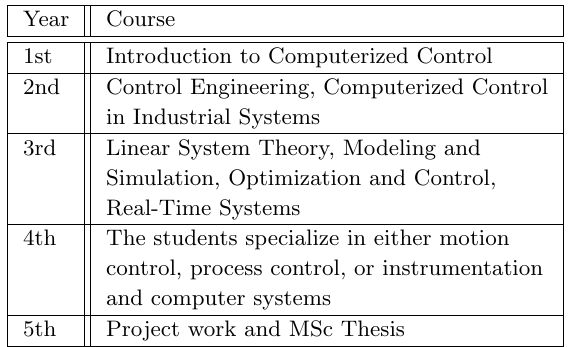
Table 1: Control-related courses in the Department